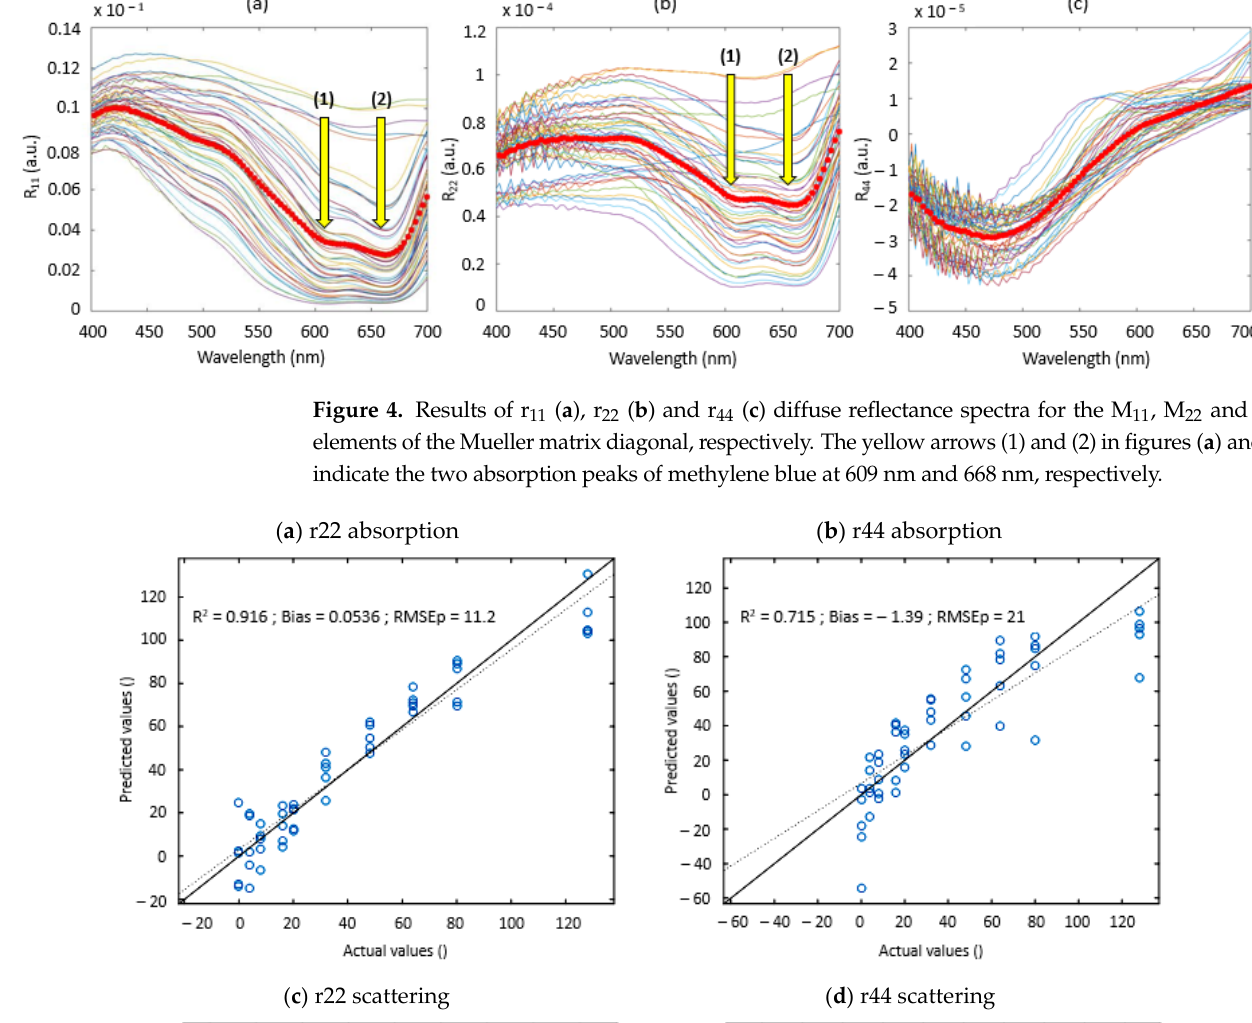
Figure 4. Results of r 11 ( a ), r 22 ( b ) and r 44 ( c ) diffuse reflectance spectra for the M 11 , M 22 and M 44 ele- ments of the Mueller matrix diagonal, respectively. The yellow arrows (1) and (2) in figures ( a ) and ( b ) indicate the two absorption peaks of methylene blue at 609 nm and 668 nm, respectively.